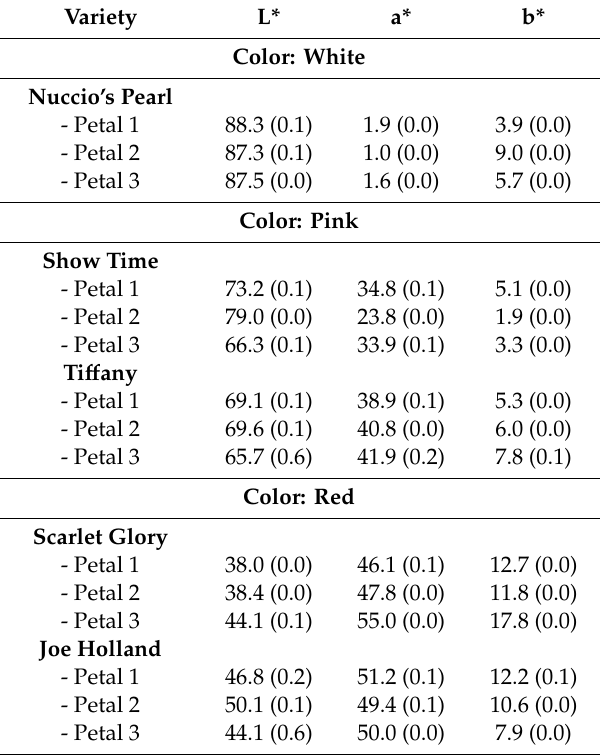
Table 4. Mean (standard deviation) of three Nix TM Pro color sensor readings from one location within each of three sampled petals from the same camellia plant for each sampled